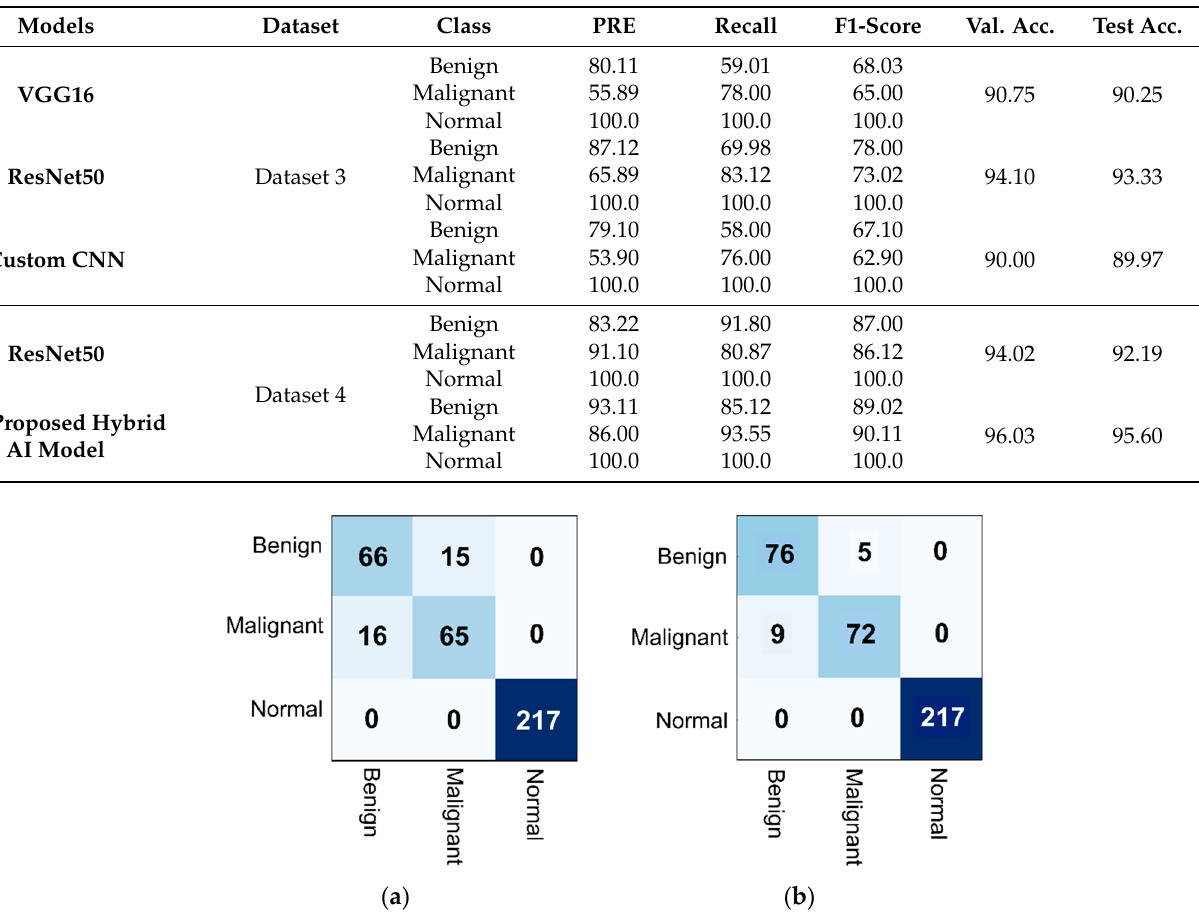
Table 10. Multi-class classification evaluation performance (%) among different AI models using dataset 3 and dataset 4.